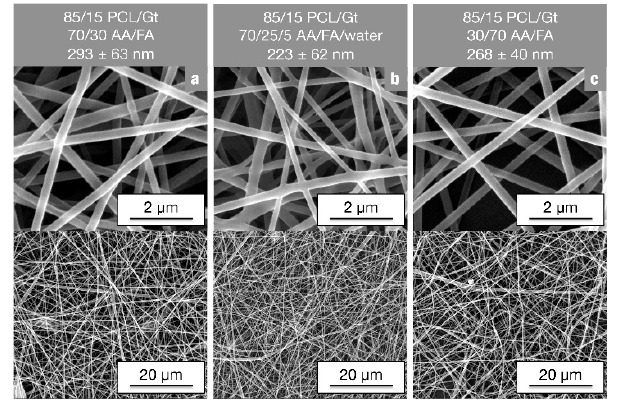
Figure 3. SEM images of 85/15 PCL/Gt nanofibers produced using a polymer concentration of 13 wt% but with differing solvent systems: ( a ) An emulsion unstable in time; ( b ) An emulsion stable in time, and; ( c ) A clear solution stable in time.